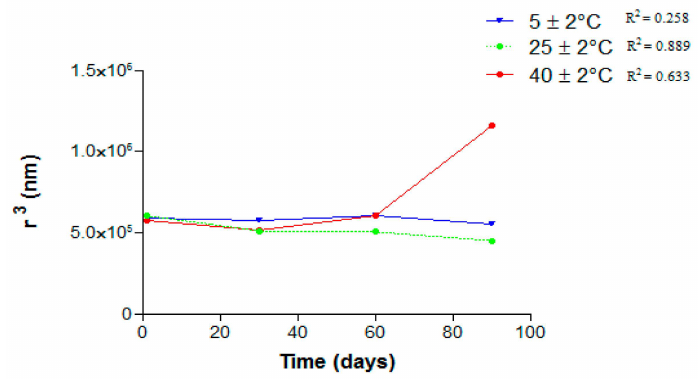
Figure 9. r 3 in function of time of NE-AL